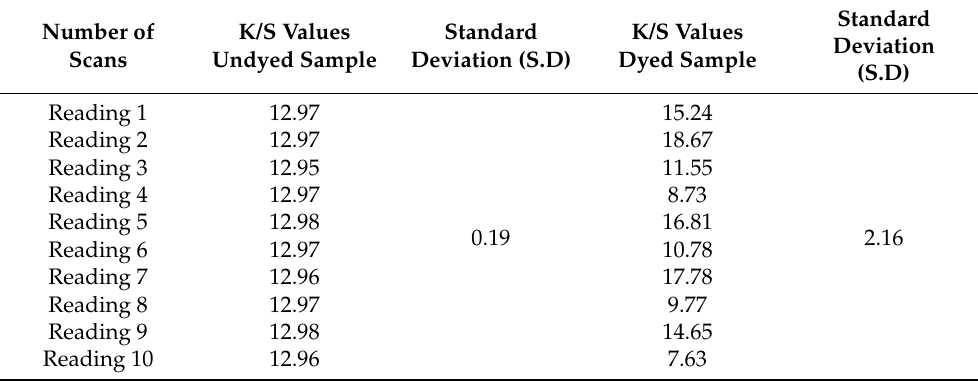
Table 4. Reflectance measurements for the undyed and dyed copper-coated fabrics.